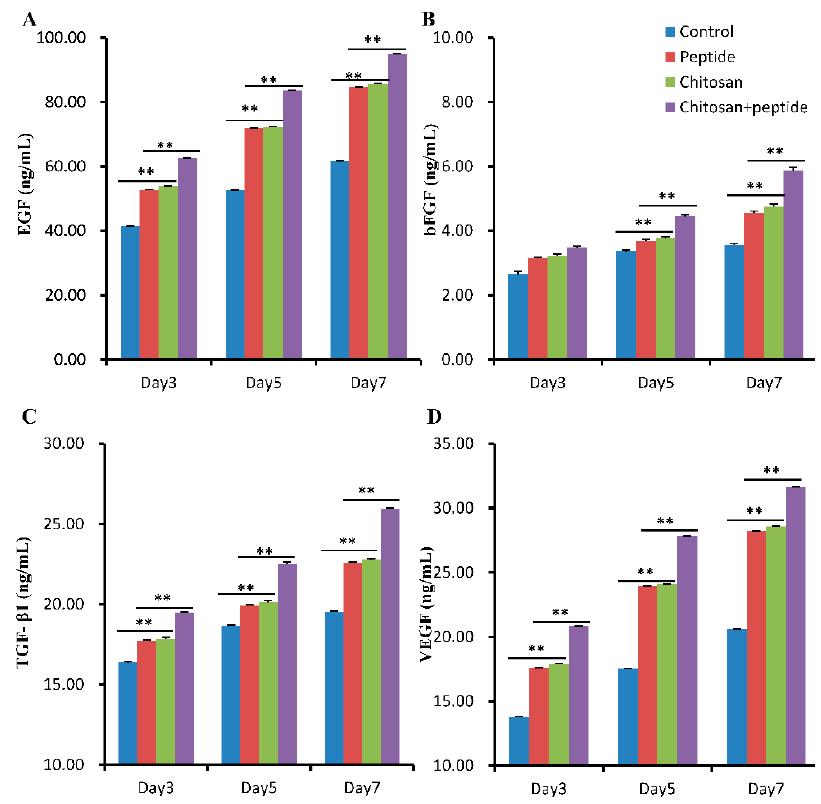
Figure 5. An ELISA assay detected the secretion of EGF ( A ), bFGF ( B ), TGF- β 1 ( C ), and VEGF ( D ) in the skin wounds of mice on days 3, 5 and 7 after trauma in the control, SIKVAV, chitosan, and SIKVAV-modified chitosan groups ( n = 3, ** p < 0.01.).